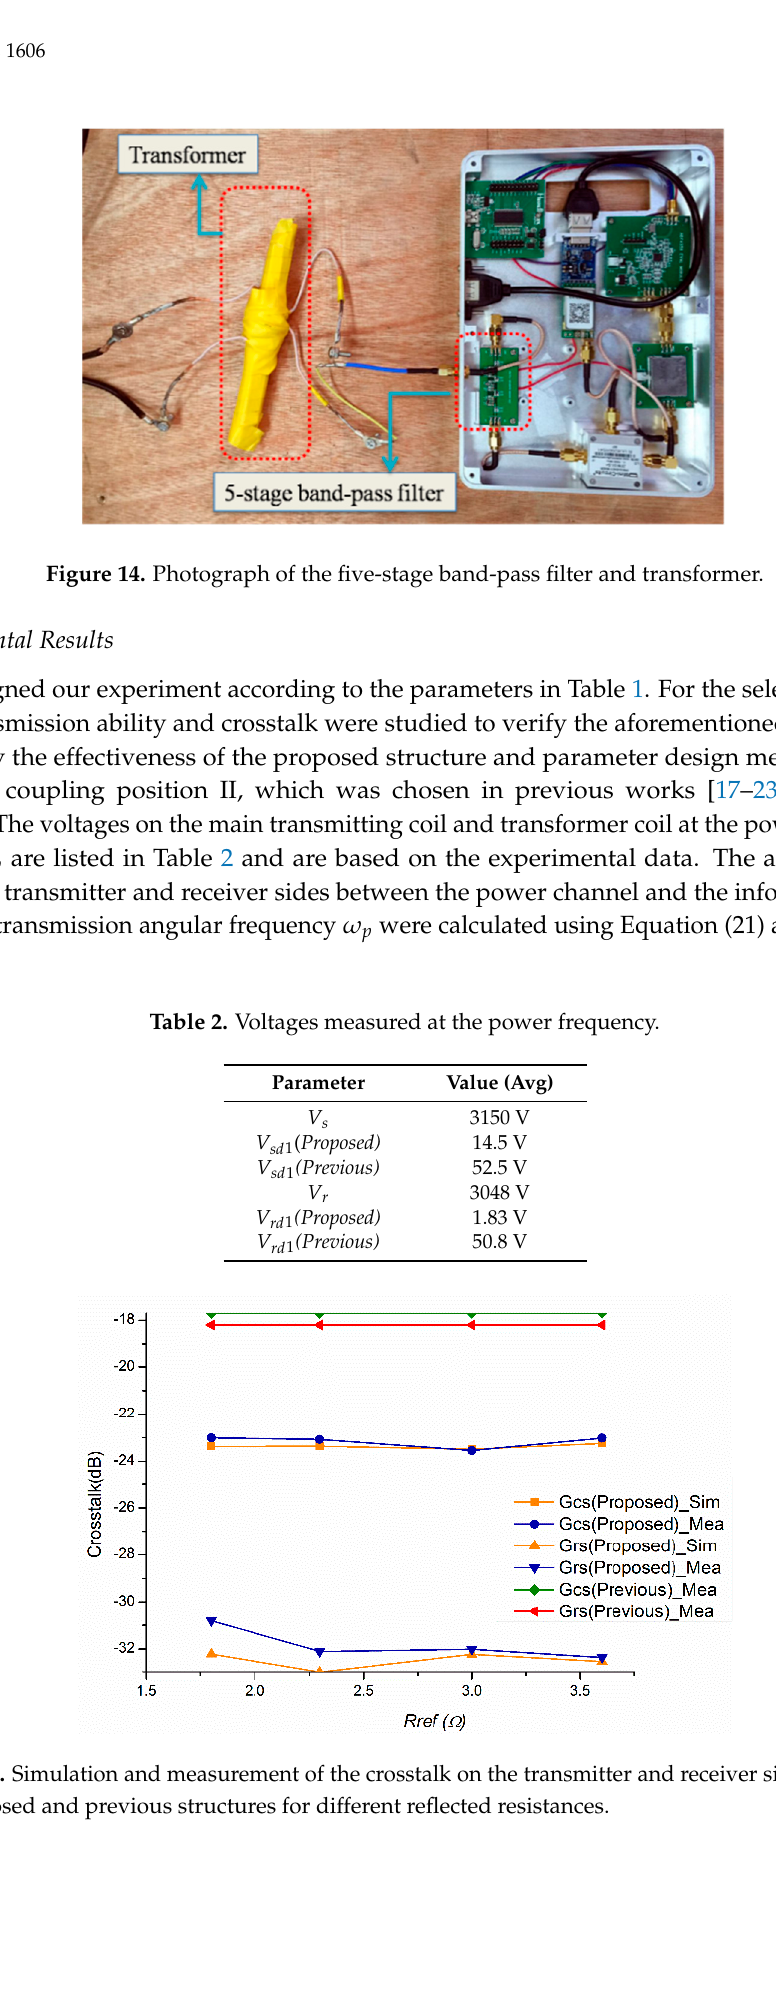
Figure 13. Photograph of the transmission gain at the communication frequency.